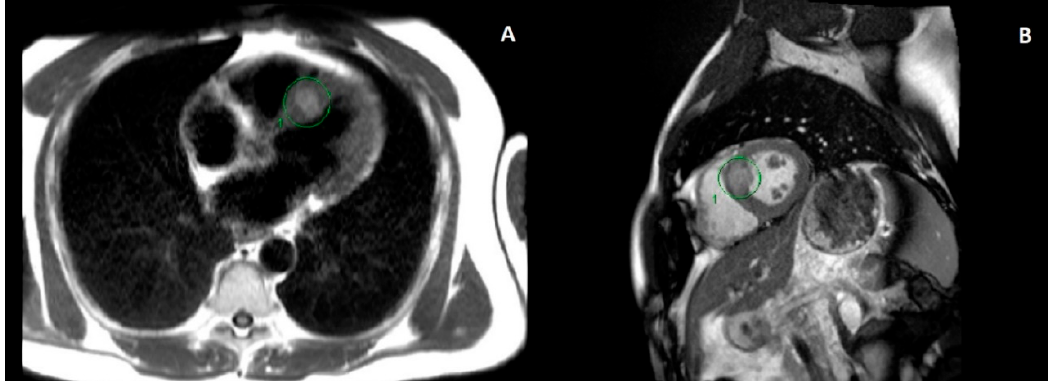
Figure 1. Magnetic resonance imaging (MRI) of the thorax and upper abdomen using gadolinium contrast and cardiac gating. Images from left to right show axial ( A ) and sagittal ( B ) views of the metastatic myocardial septum lesion (circled) prior to any treatment.